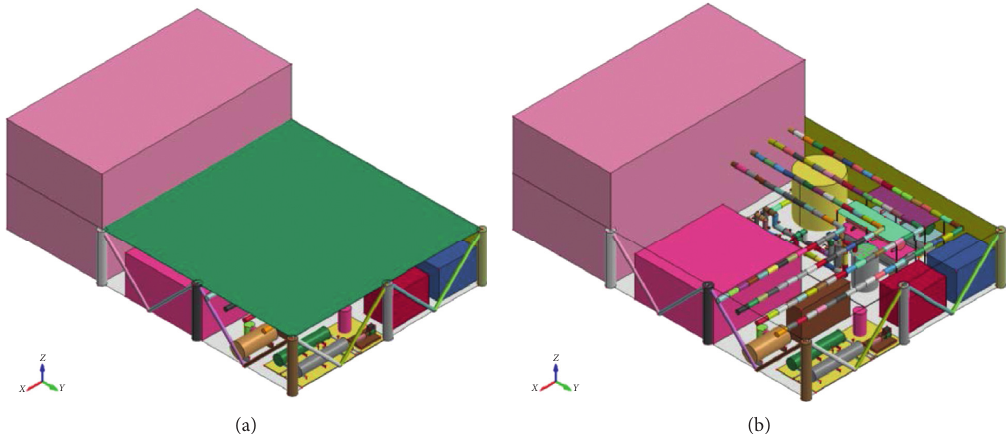
Figure 4: 3D geometrical model of considered example platform. (a) General view. (b) Inner equipment.